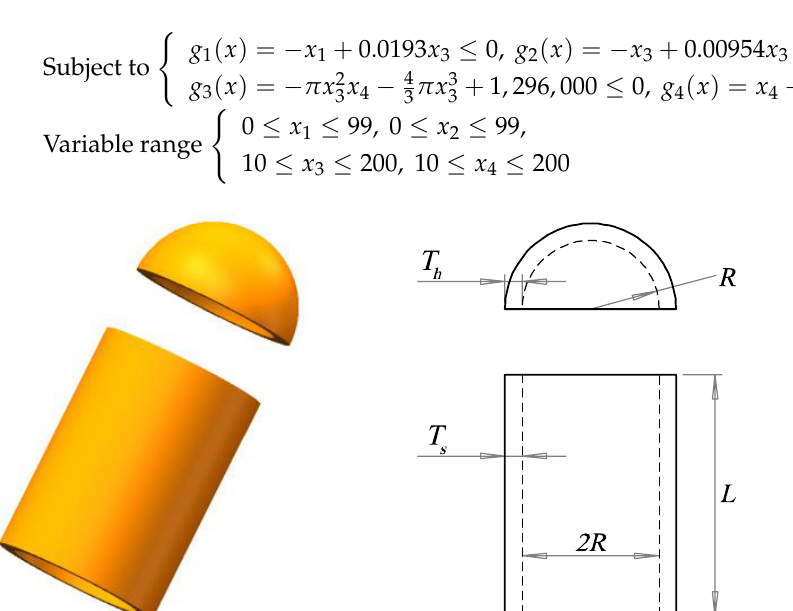
Figure 10. Pressure vessel design problem.